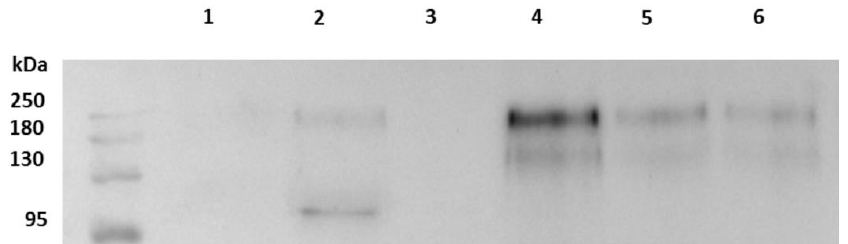
Figure 4. Quantification by Western blot analysis of spike protein in cell culture supernatants. Lines 1 and 2: cell culture supernatants infected with SARS-CoV-2, Wuhan strain, harvested at 24 and 48 h respectively. Line 3: non-infected cell culture supernatant. Lines 4, 5 and 6: recombinant SARS-CoV-2 spike protein at 2.25, 1.25 and 0.56 ng/µL respectively.